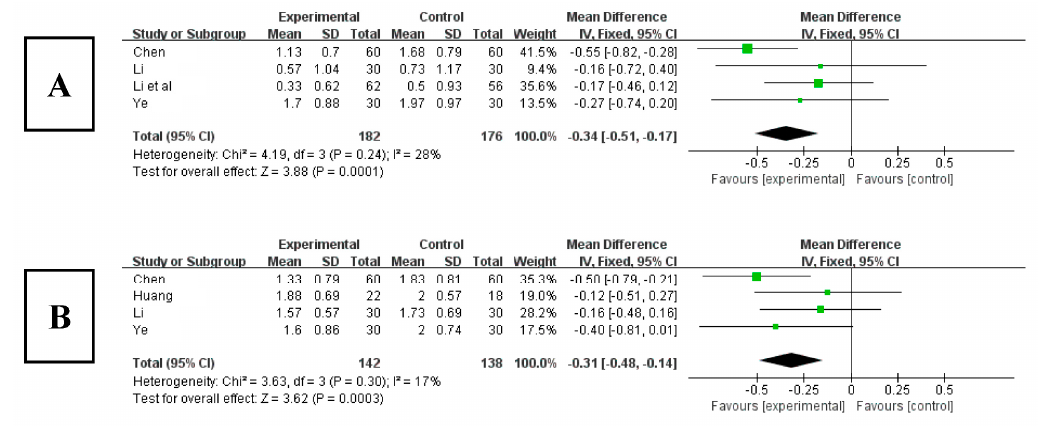
Figure 9. ( A ) Forest plot of effect size of hypnotics. ( B ) Forest plot of daytime dysfunction effect size.